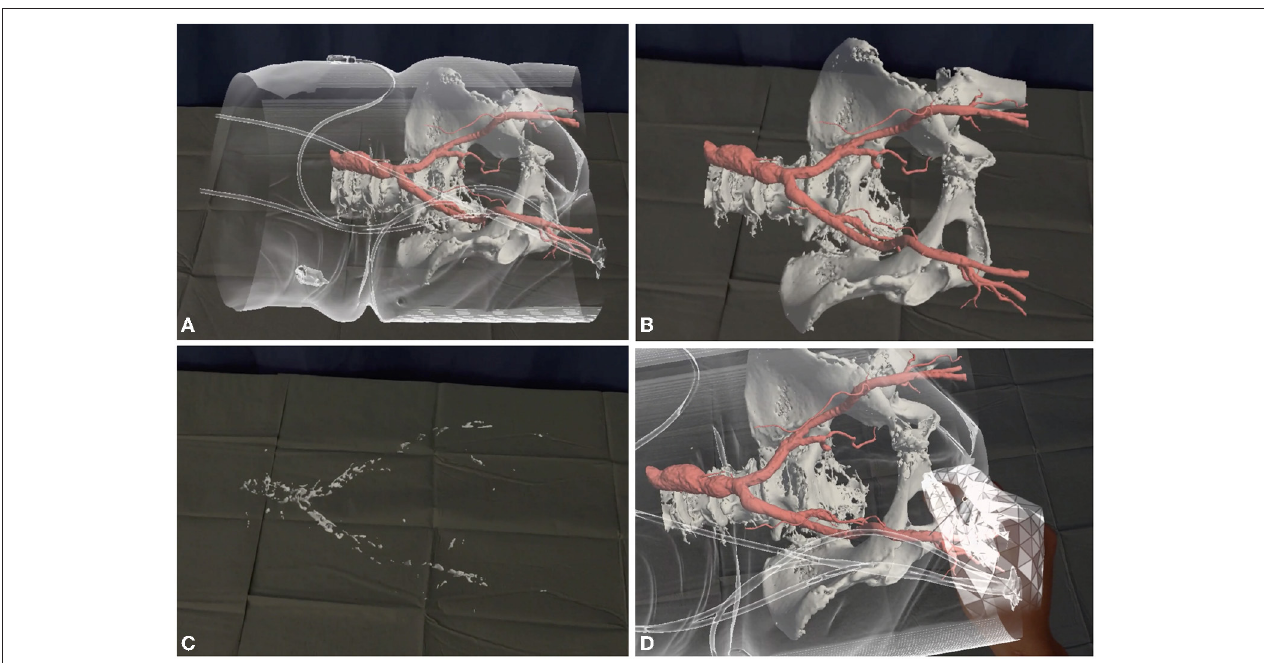
FIGURE 1 | Augmented reality can simplify vascular access. The patients’ CT scan is reconstructed with a proprietary software (Articor, Artiness SRL, Milano, Italy) to generate 3D holograms, that can be moved to the hybrid room and visualized with commercial holographic viewers (Hololens 2, Microsoft Inc, Redmonds, Washington, US). (A) The patients’ arterial tree is seen through the transparent skin surface. (B, C) Different layers can be visualized or removed, to analyze different aspects of the vascular access (size, tortuosity, calcifications). (D) A dedicated tool can be used to simulate vascular